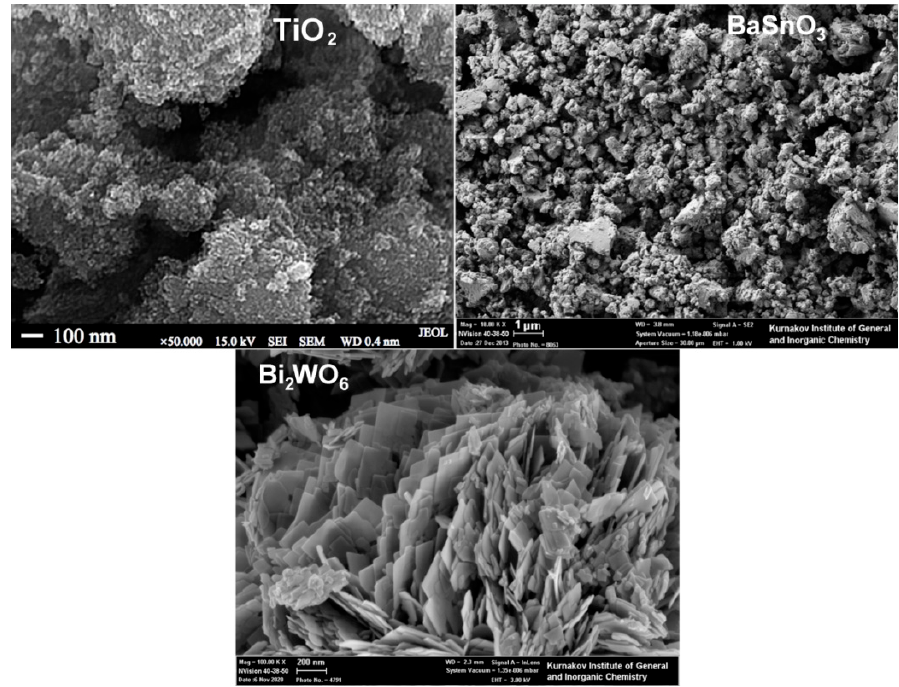
Figure 10. SEM images of nanocrystalline TiO 2 , BaSnO 3 , and Bi 2 WO 6 . Adapted with permissions from ref. [63] copyright 2021 Elsevier; ref. [77] copyright 2015 by the authors (CC BY); ref. [96] copyright 2021 Springer Nature. Table 2. Concentration of active sites at the surface of n -type MOS obtained at different annealing temperature ( T anneal ) and having different mean crystallite size ( d XRD ) and specific surface area (SSA) [63,76–79,94,96]. MOS T anneal , ◦ C d XRD ,